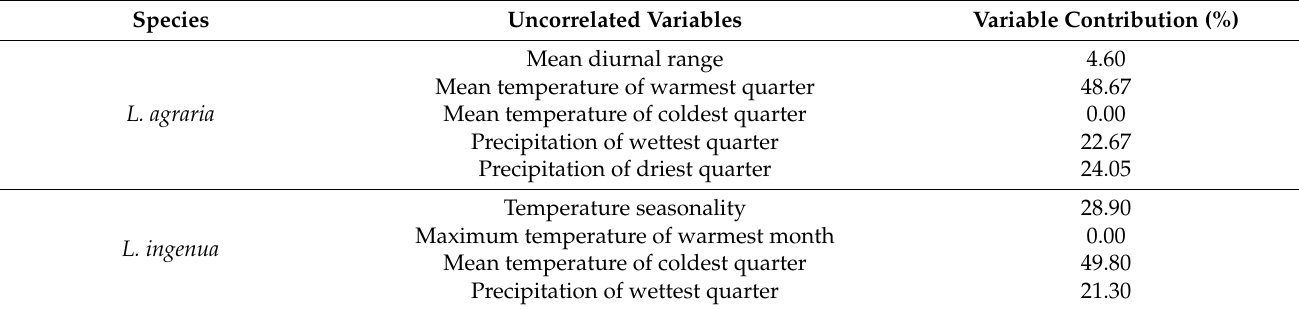
Table 2. Models and variables that were relatively uncorrelated (Pearson’s correlation ≤ 0.8) for Lycoriella species. The models were built and tested used 26 variables sets for L. agraria , 247 variables sets for L. ingenua , and 120 variables sets for L. sativae